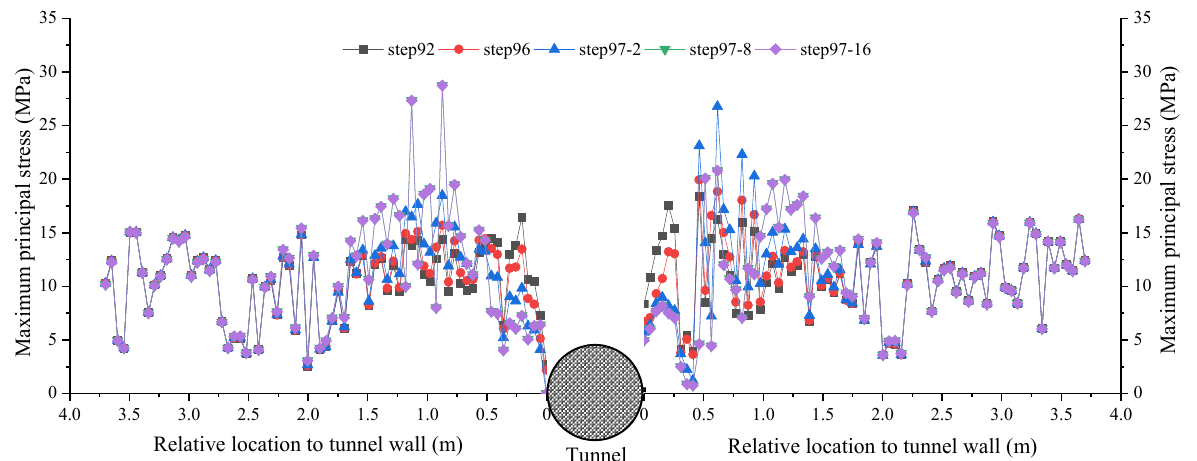
Figure 15. The maximum principal stress-transfer process of surrounding rock during zonal disin- tegration formation in Model C.